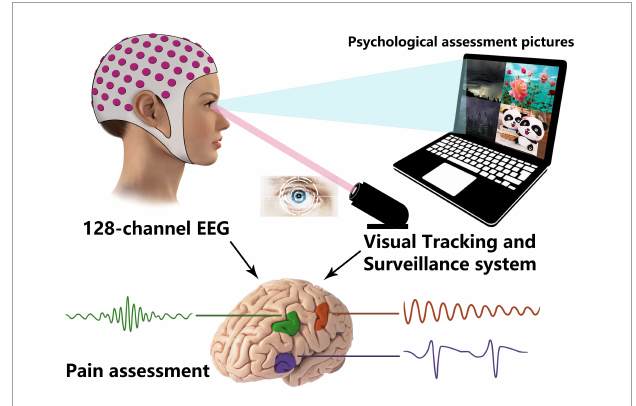
FIGURE2 Combination of electroencephalography (EEG) and Visual Tracking and Surveillance System in pain